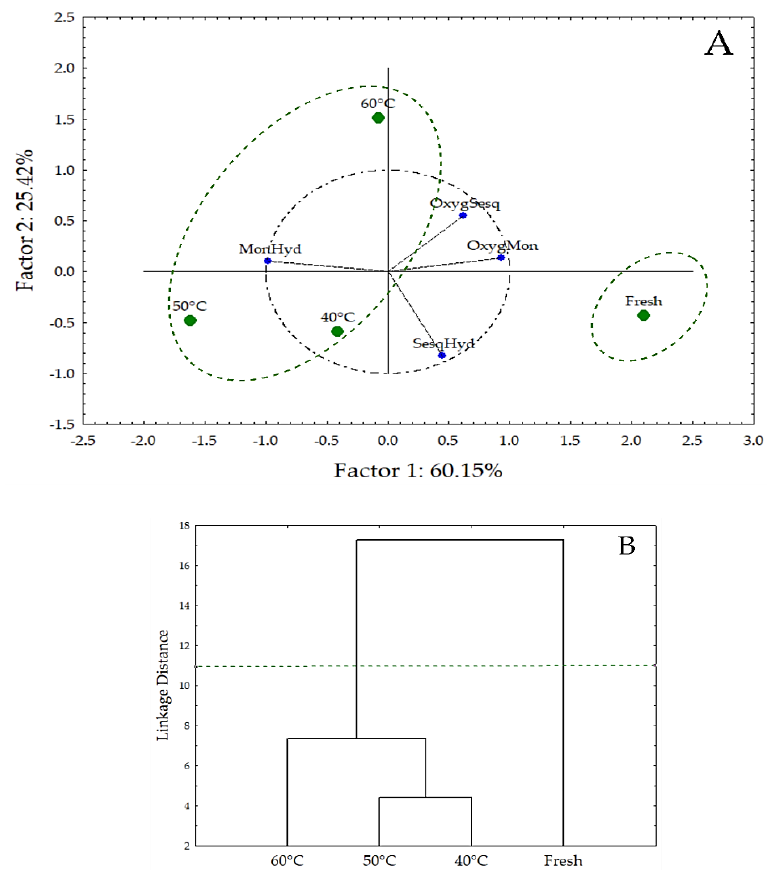
Figure 2. Multivariate analysis using data from the chemical composition of essential oils obtained from fresh and dried Lippia thymoides leaves. ( A ) Principal component analysis (PCA); MonHyd: Monoterpene hydrocarbons; OxygSesq: Oxygenated sesquiterpene; OxygMon: Oxygenated monoter- penes; SesqHyd: Sesquiterpene hydrocarbons. ( B ) Hierarchical cluster analysis (HCA). The dashed green lines indicate the identified